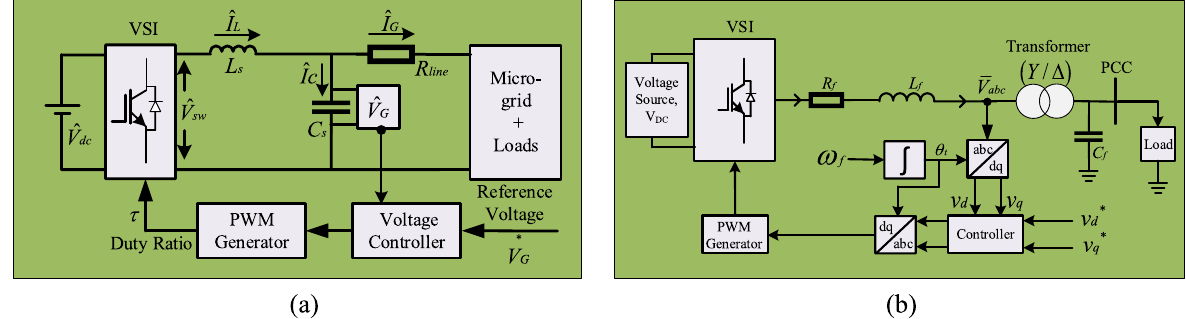
Fig. 2 Closed‑loop configuration of MG technology for a single‑phase system and b three‑phase